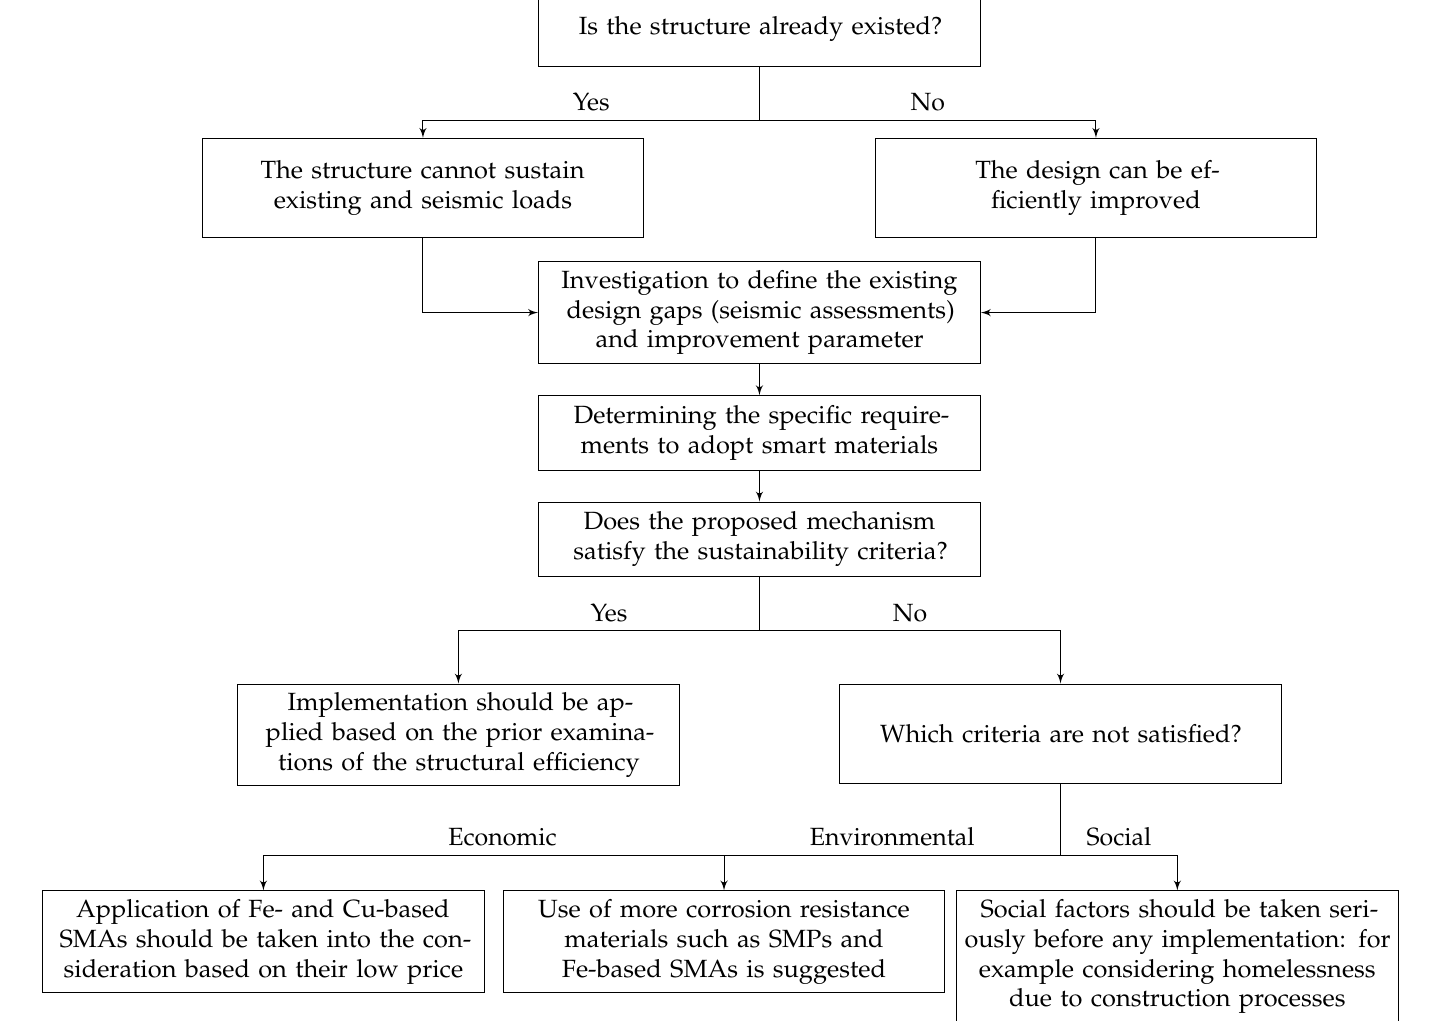
Figure 25. A generic algorithm for using smart materials maintaining sustainability